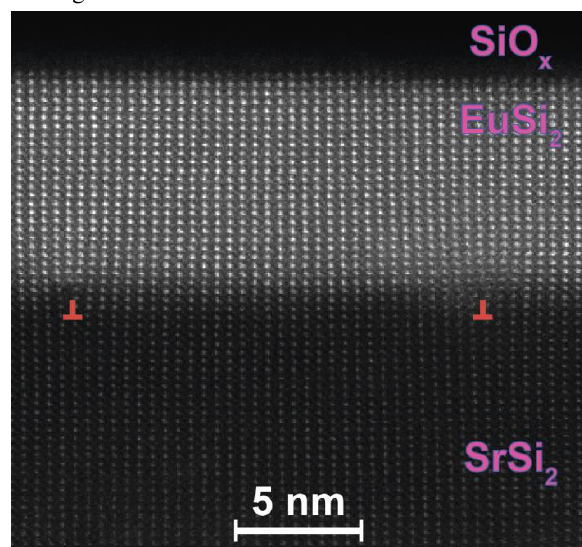
Fig. 3. Cross-sectional HAADF-STEM image of the SiO x /EuSi 2 /SrSi 2 /Si(001) film. Edge dislocations in EuSi 2 are marked by red pointers.